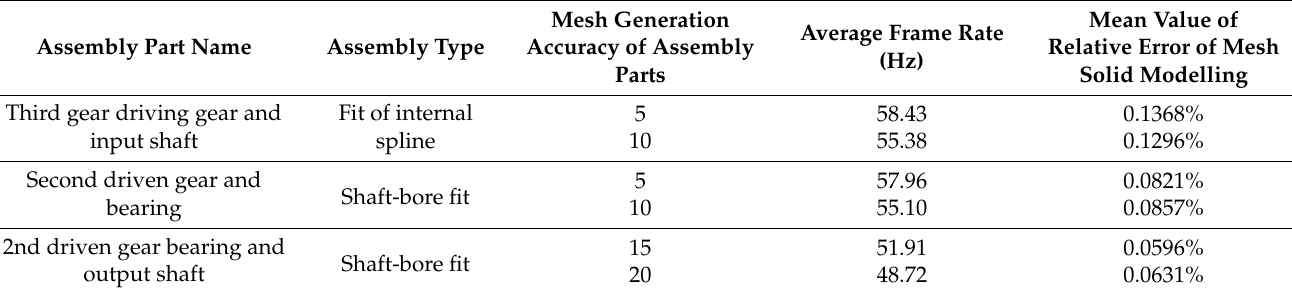
Table 5. Fitting error data of the part mesh solid